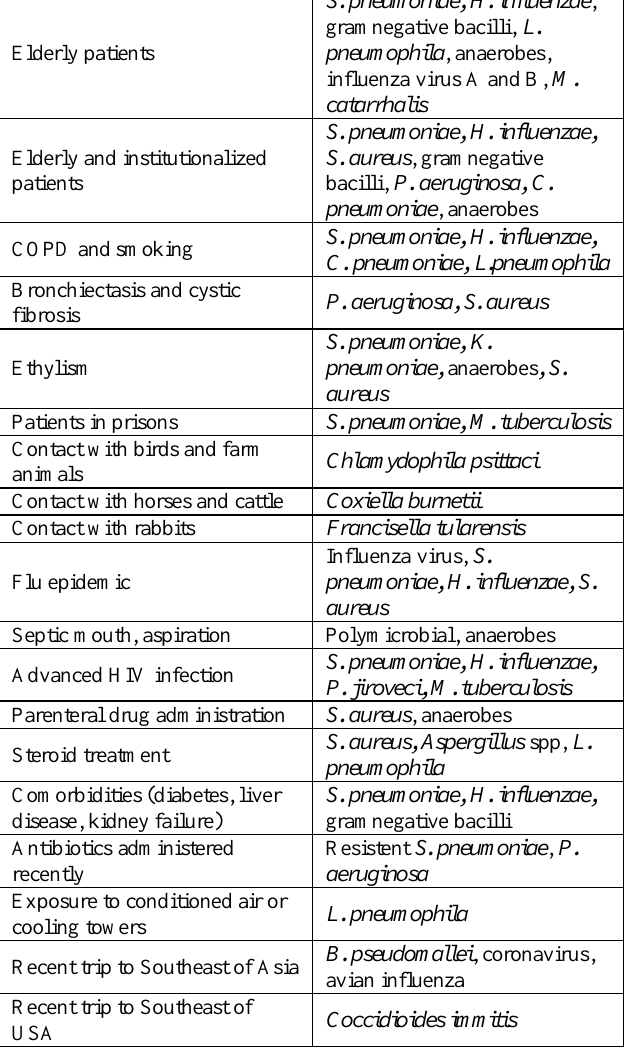
Table 2: Clinical-epidemiological conditions related to specific pathogens. COPD: chronic obstructive pulmonary disease; HIV: Human immunodeficiency virus; USA: United States of